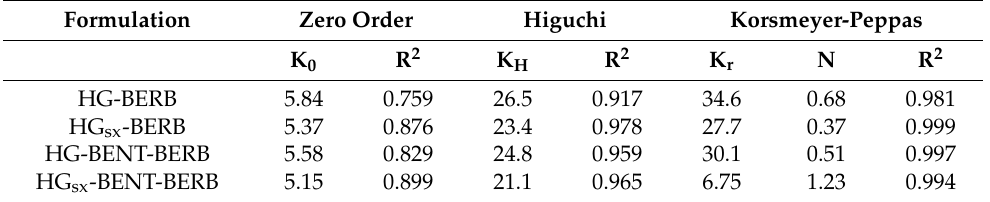
Table 1. Kinetic modelling of BERB release. Application of three different models to fit in vitro permeation data.